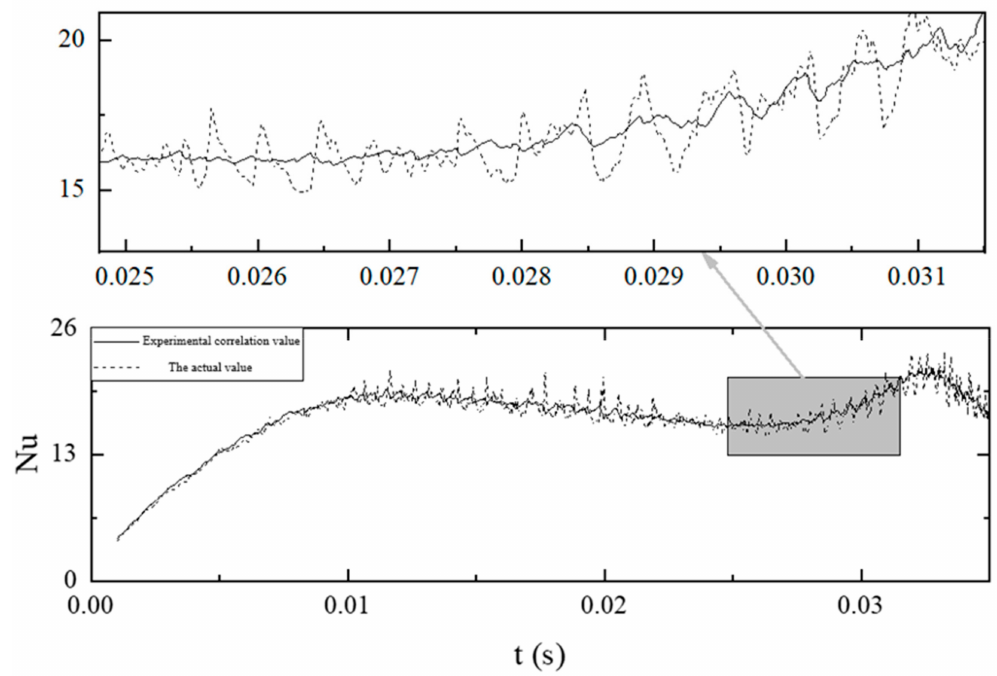
Figure 1. Comparison of the actual value for Nusselt number with Kim’s experimental correlation value.